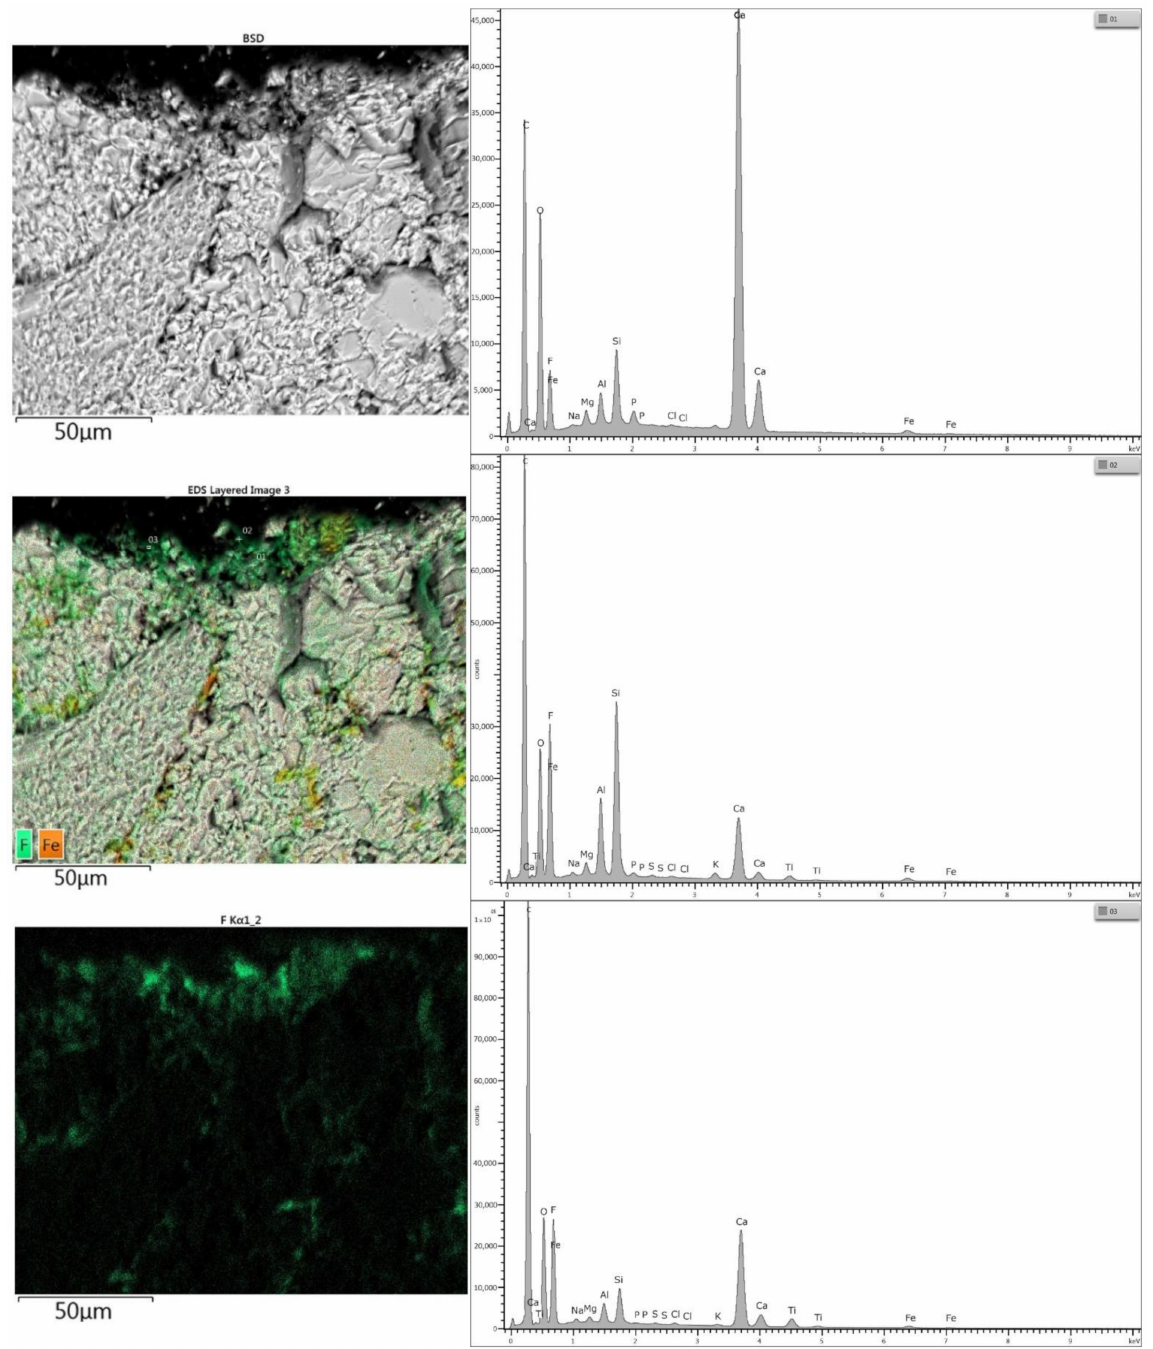
Figure 9. SEM-EDS images: Section mapping and point elemental analysis: sample treated with NSO product (University of Bari Aldo